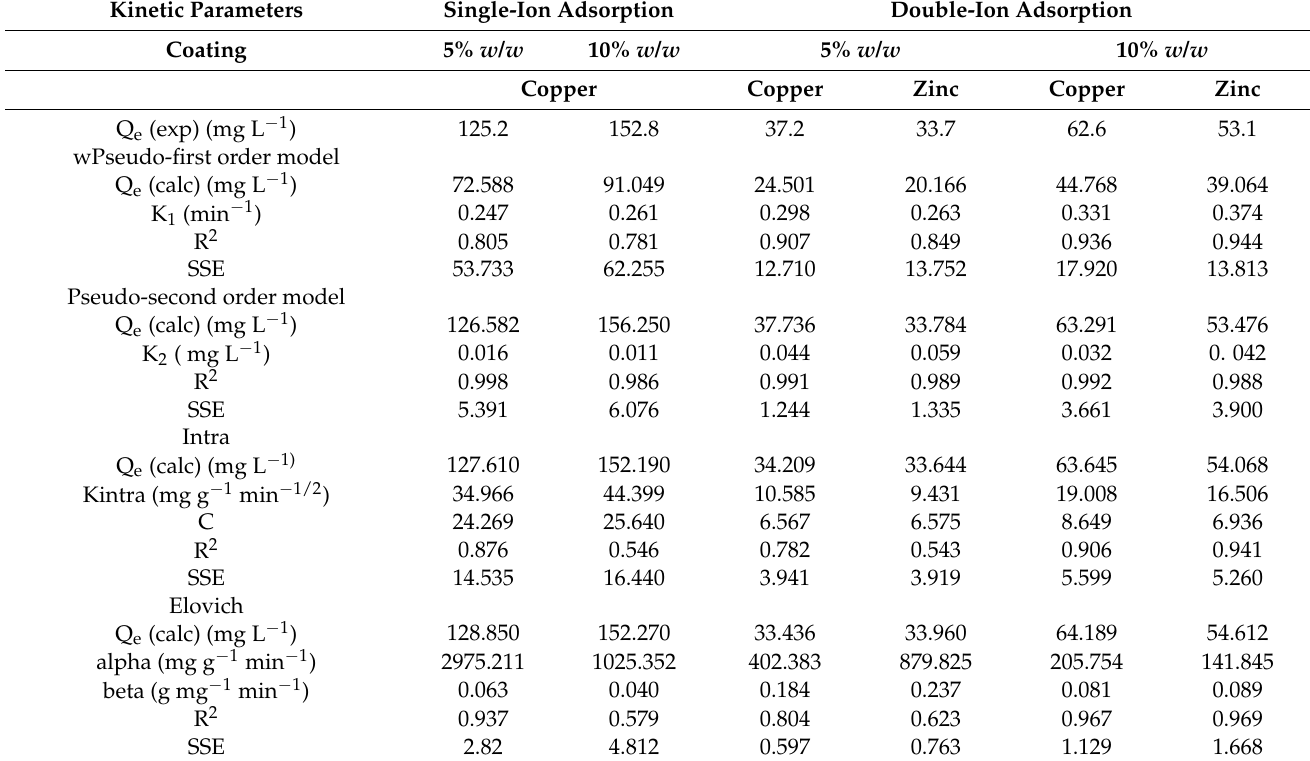
Figure 17. The fitting of different kinetic models for double-ion adsorption (Cu 2+ and Zn 2+ ) onto MA functionalized with 10% of coating, ( a ) pseudo-first-order, ( b ) pseudo-second-order, ( c ) Elovich model, and ( d ) intra-particle diffusion model. All the parameters of the different models calculated from the regressions are reported in Table 3. For all the regression, the sum of error squared (SSE) between the predicted values and the experimental data was measured. The best results in terms of higher correlation coefficients (R 2 ) with low SSE values were obtained, with the pseudo-second-order kinetic model indicating that the adsorption mechanism is dependent on the adsorbate and the adsorbent [12,38]. This result was indeed expected since the adsorption model is based on the interaction between the negative charges present on the surface of the MA and the positive charges of metal ions. Table 3. Kinetic parameters of the different models for single-ion and double-ion adsorption onto functionalized MA. Kinetic